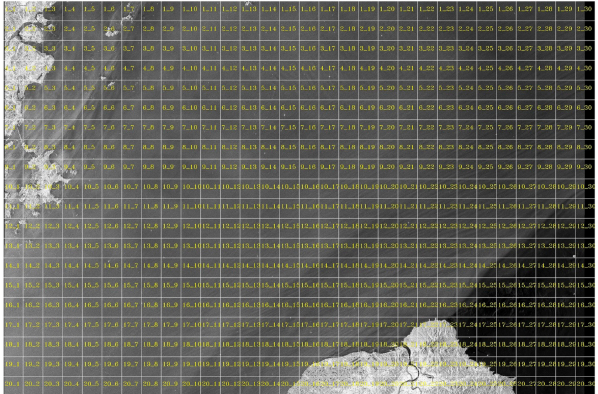
Figure 4. Image cutting process taking the 11.jpg as an